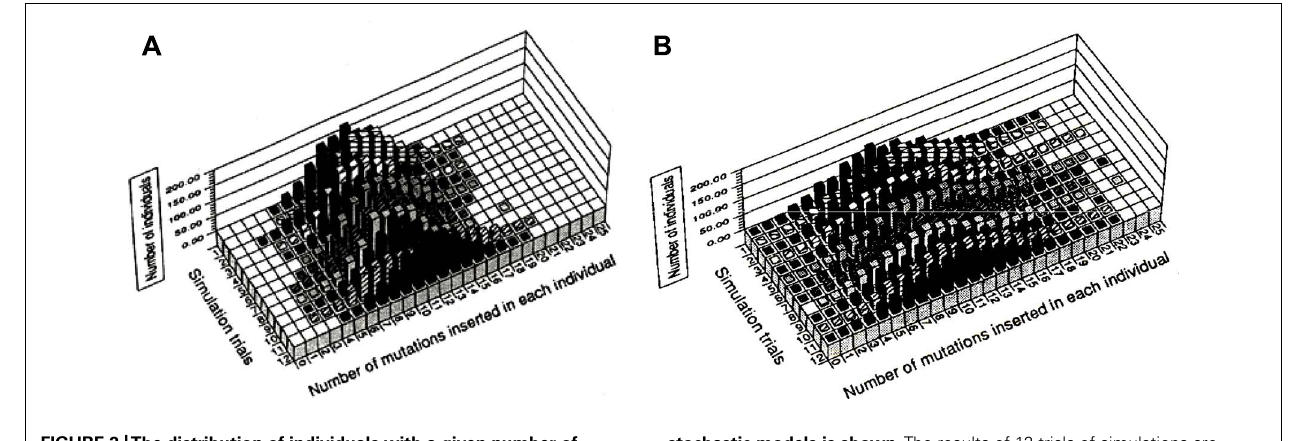
FIGURE 2 |The distribution of individuals with a given number of mutations in the tenth generation for the parity (A) and disparity (B)